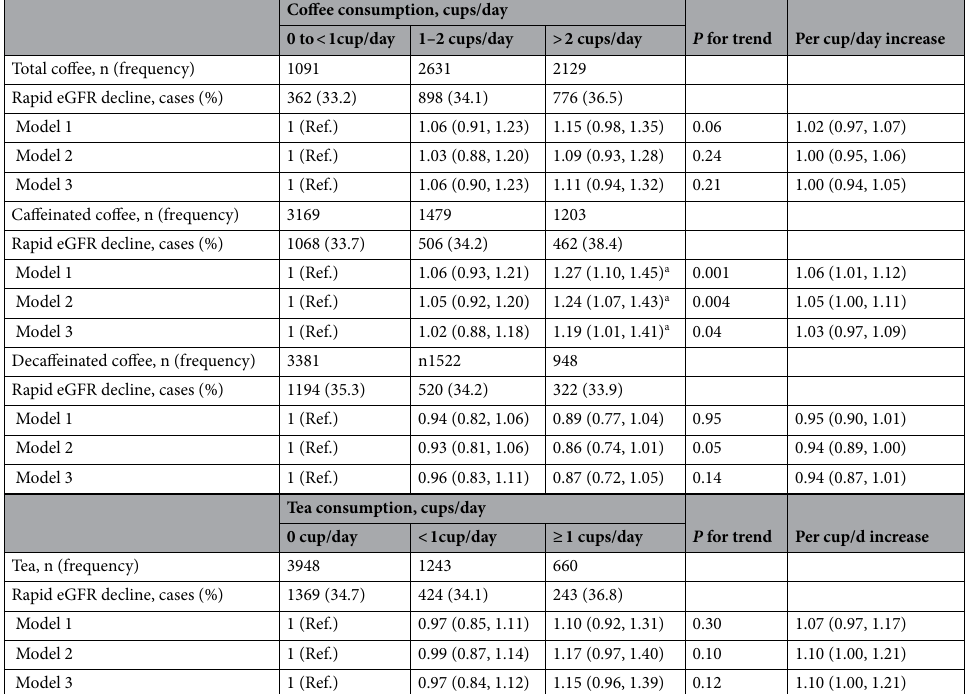
Table 3. Odds ratio (95% confidence intervals) of rapid eGFR decline (1-year changes in eGFR > 3 mL/ min/1.73 m 2 ) according to categories of coffee and tea consumption at baseline. Values are means (95% CI) unless otherwise indicated. eGFR estimated glomerular filtration rate, Ref. referent value. P value for trend based on multivariate logistic regression treating the median values of each category as an ordinal variable. Model 1: adjusted for sex (men or women), age (years, continuous), and baseline eGFR (mL/min/1.73 m 2 , continuous). Model 2: additionally adjusted for BMI (kg/m 2 , continuous), smoking (never, current, or